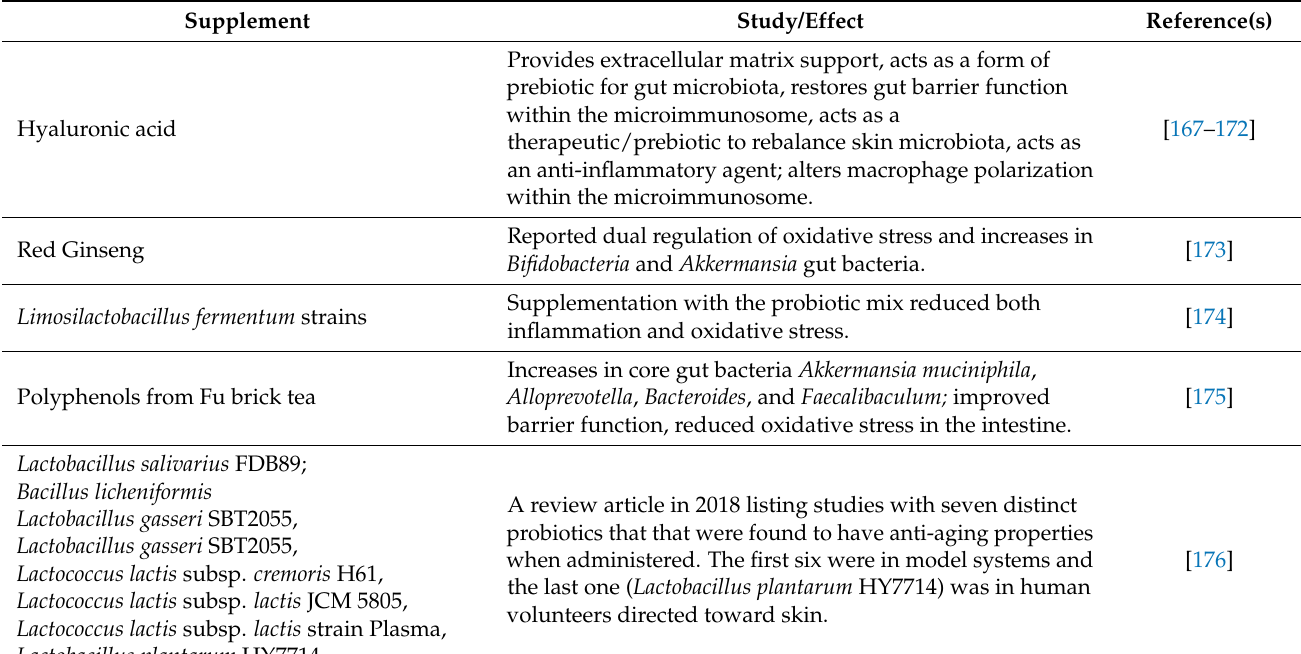
Table 9. Examples of Microbiome-Altering, Inflammation Reducing, and/or Anti-Aging